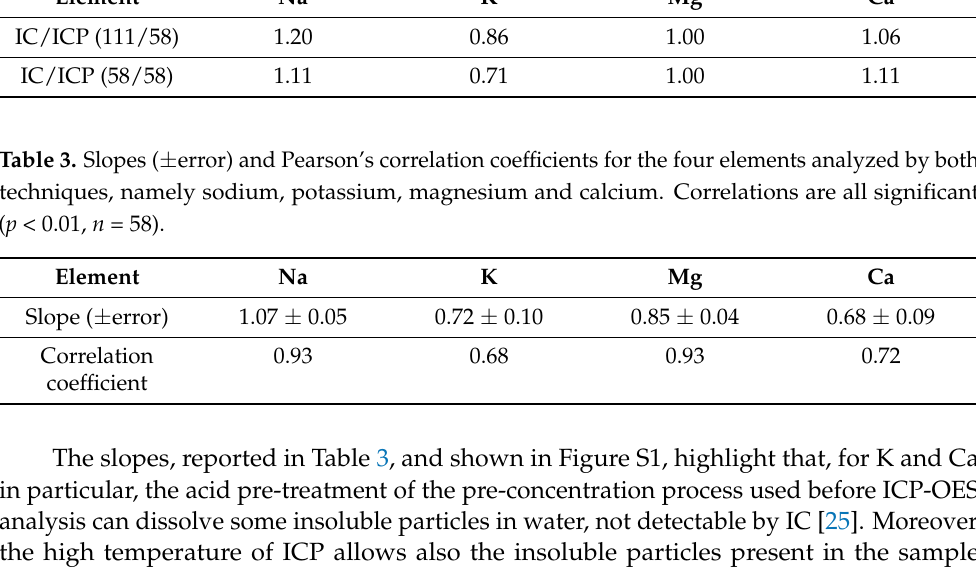
techniques. In brackets, the numbers of the samples considered for each technique are specified. Element Na K Mg Ca IC/ICP (111/58) 1.20